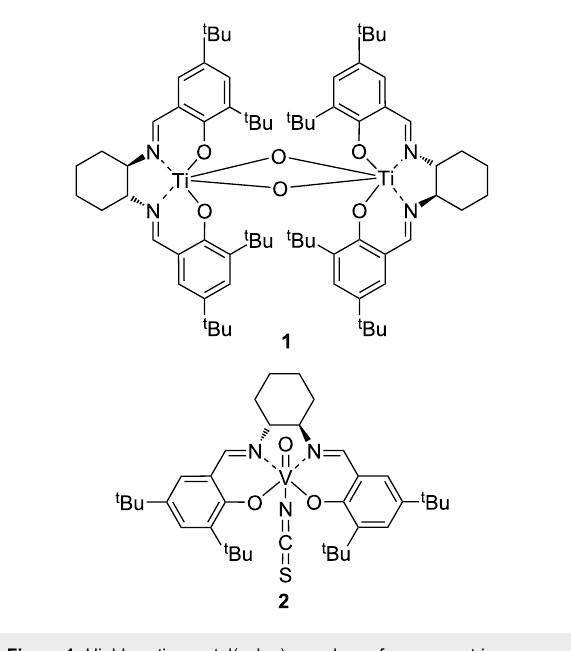
Figure 1: Highly active metal(salen) complexes for asymmetric cyanohydrin